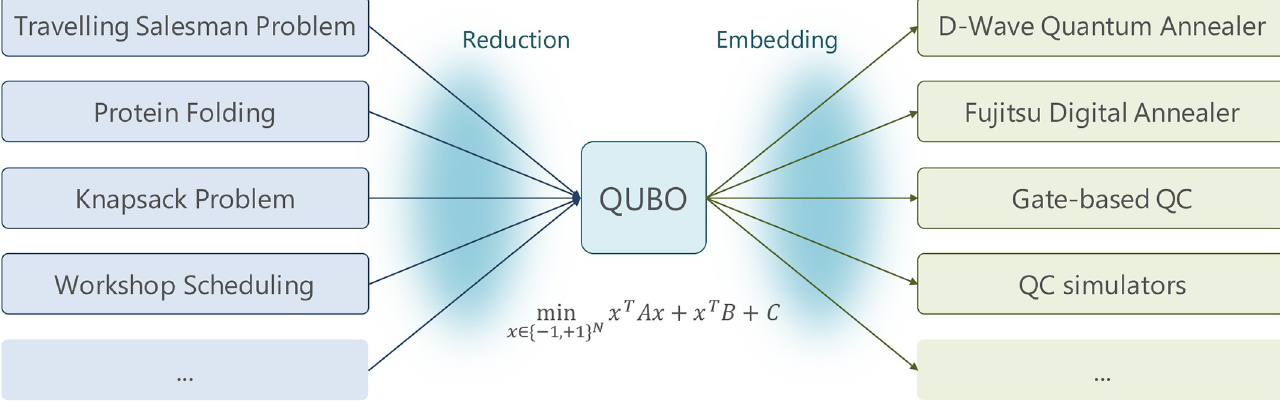
Fig 3. QUBO reduction from NP-hard